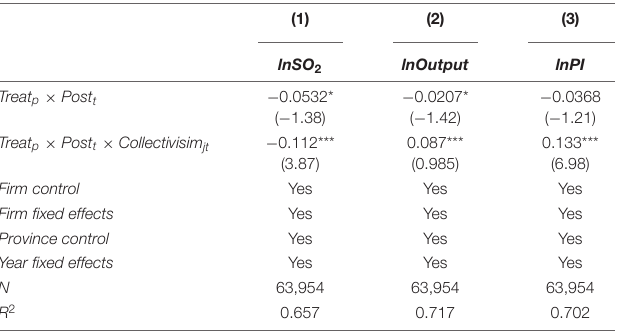
TABLE 4 | Chief executive officer (CEO) collectivism and corporate pollution behavior after the policy